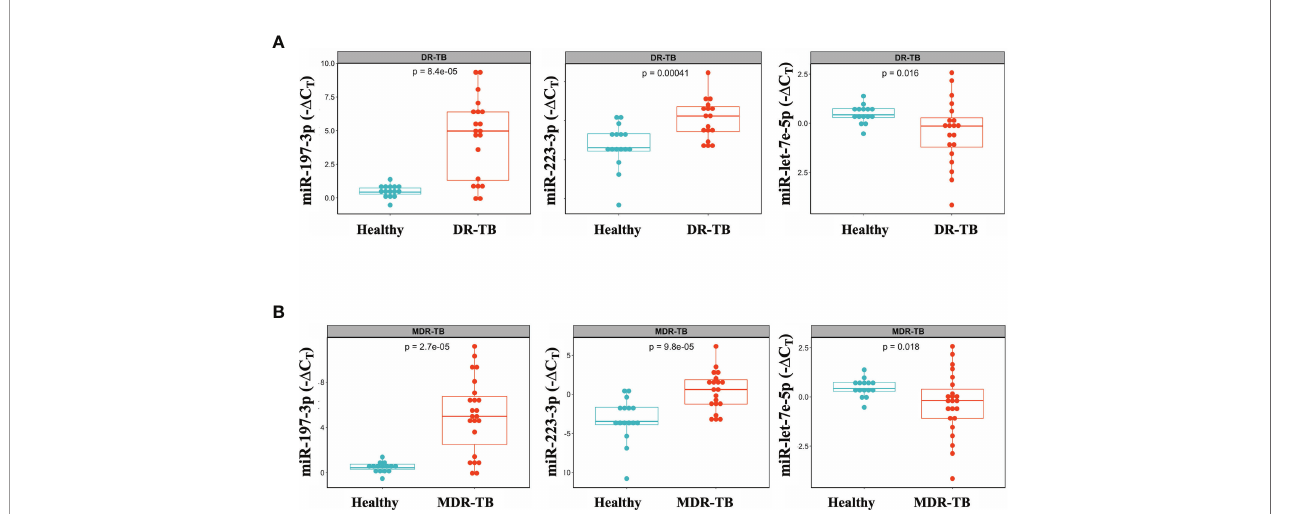
FIGURE 2 | Differential miR-let-7e-5p, miR-197-3p and miR-223-3p expression in serum exosomes from DR-TB patients and healthy subjects. Serum exosomes were isolated, miRNAs ampli fi cation was done by qPCR. The data were expressed as D C T , de fi ned as the relative expression of each miRNA with respect to the endogenous control (mirR-145-5p). Box plots depict medians and quartiles. (A) DR-TB patients (n = 24) and (B) MDR-TB patients (n = 20) and healthy subjects (n = 16), p < 0.05, (TB vs. Control), DR, Drug Resistant; MDR, Multi Drug Resistant. Raw C T data were normalized, and expression differences between cases and controls were assessed by an unpaired two-samples Mann-Whitney test. Only statistical differences with p < 0.05 are